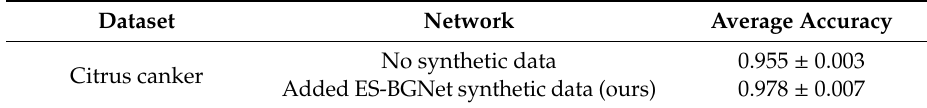
Figure 8. Contrast through transfer learning. When synthetic data (1000 images) was not used and ES-BGNet synthetic data training (1500 images) was used, we obtained the classification accuracy of AlexNet using the citrus canker dataset. Table 2. Contrast between not using synthetic data and using edge-smoothing binarization generator network (ES-BGNet) synthetic data to provide the average accuracy of AlexNet using the citrus canker dataset. We gathered the statistics of 10 training exercises, and the difference was statistically significant ( p < 0.05).